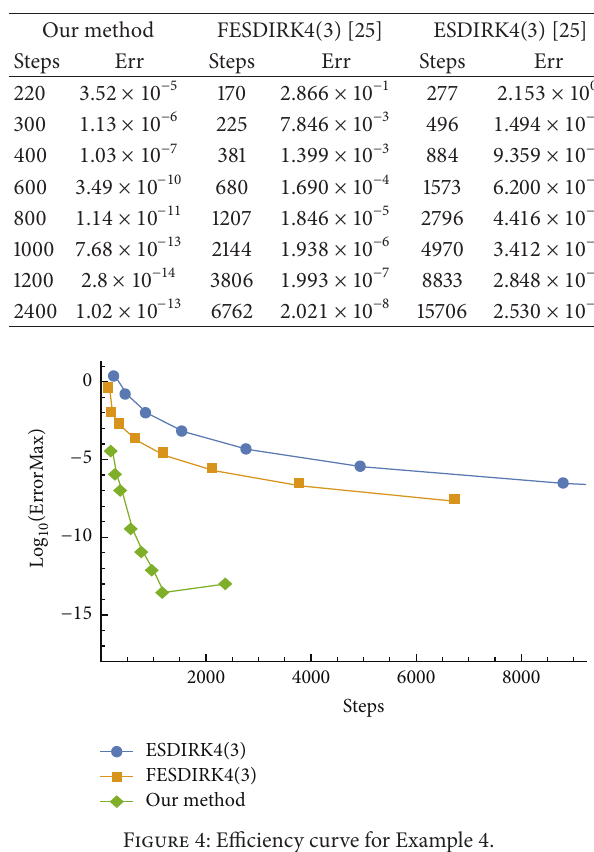
Table 4: Steps and absolute errors, with 𝜔